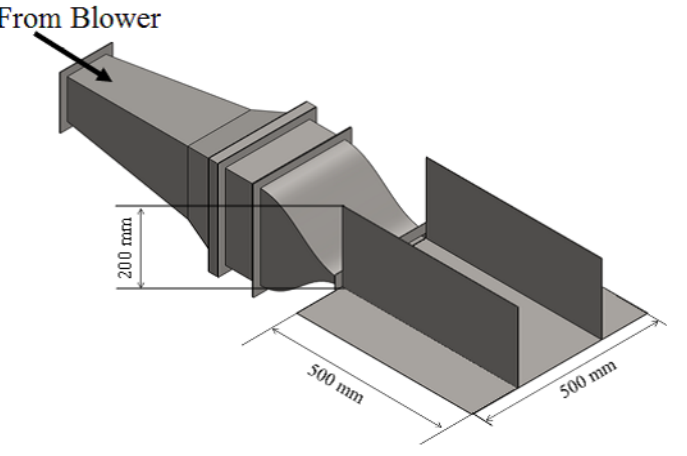
Fig. 10 Perspective view of the experimental apparatus of the wall jet.